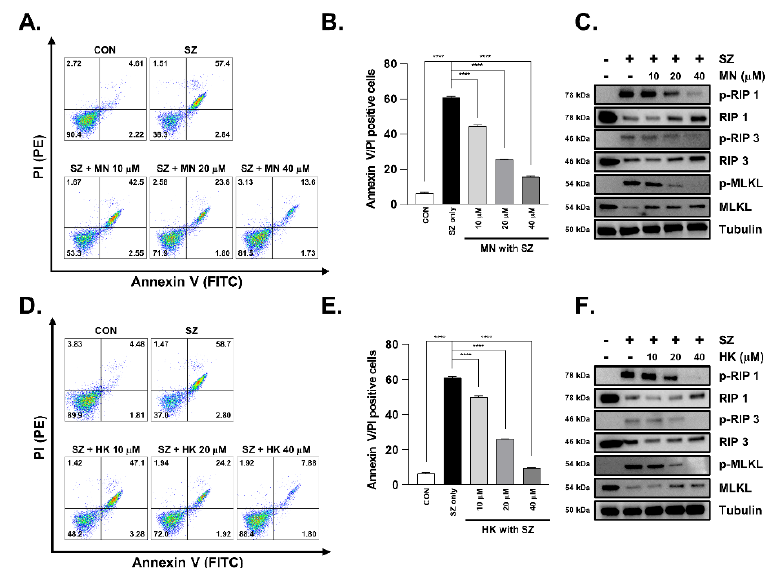
Figure 6. MN and HK inhibit SZ-induced expression of necroptosis proteins in HT29 cells. ( A and D ) HT29 cells were pretreated with MN and HK for 30 min before the treatment with SZ (Smac mimetic (100 nM) and z-VAD (20 µ M)) for 12 h. ( B ) The values represent the sum of the percentage of cells in A (PI+ annexin V+; necroptosis). ( C and F ) Protein levels of pRIP1, RIP1, pRIP3, RIP3, pMLKL, and MLKL were analyzed using western blotting. Tubulin was used as a loading control. ( E ) The values represent the sum of the percentage of cells in D (PI+ annexin V+; necroptosis). **** p < 0.0001 (data were analyzed using an ANOVA).